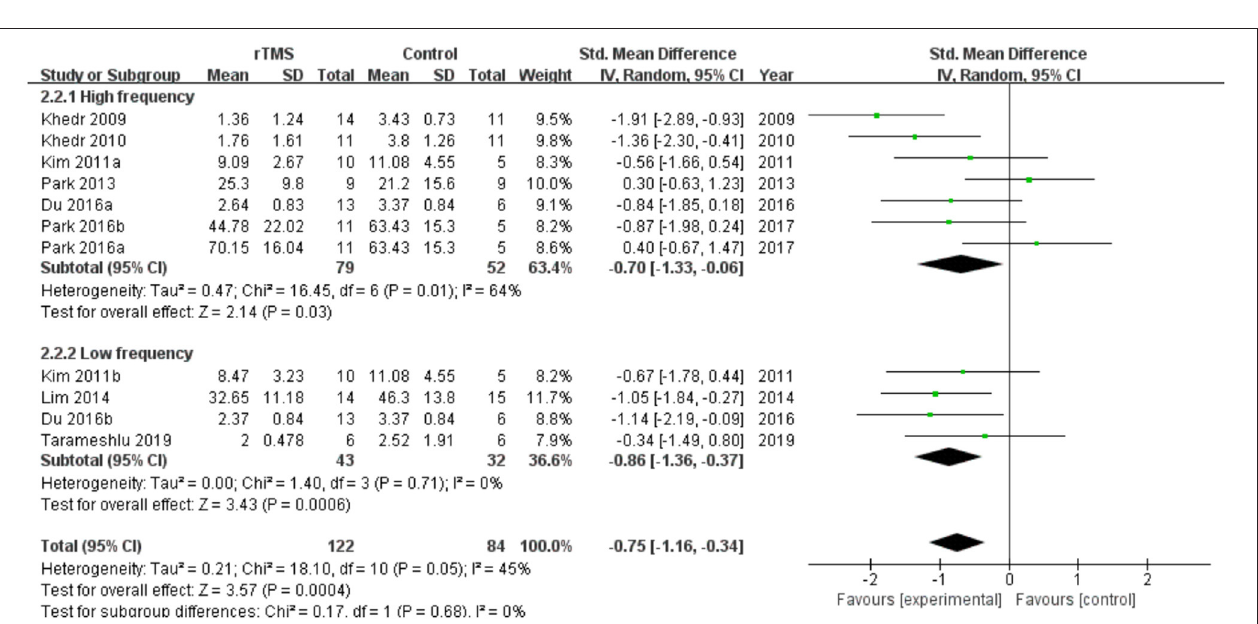
FIGURE 6 | Forest plot for subgroup analysis for overall swallowing function: low frequency transcranial magnetic stimulation vs. high frequency transcranial magnetic stimulation.